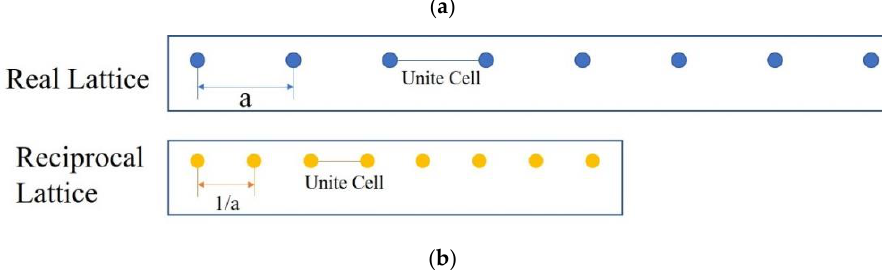
Figure 1. ( a ) A typical sample for real lattice and reciprocal lattice from c axis review, where a and b (blue dotted line) are the two lengths of real lattice while a * and b * (red line) are the two lengths of reciprocal lattice. The distance of two diffraction peaks (1/ d , where d is the distance between two lattice planes) represents one length in the reciprocal space. ( b ) Schematic illustration of the relationship between real lattice and its reciprocal lattice of single crystals.